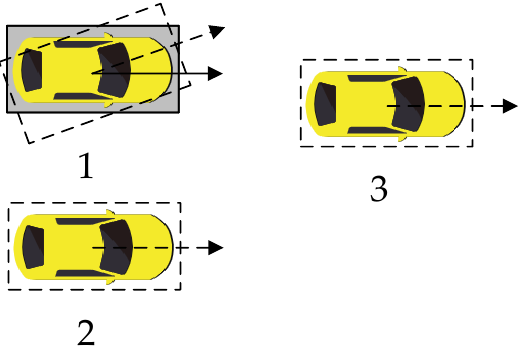
Figure 6. Different driving states.